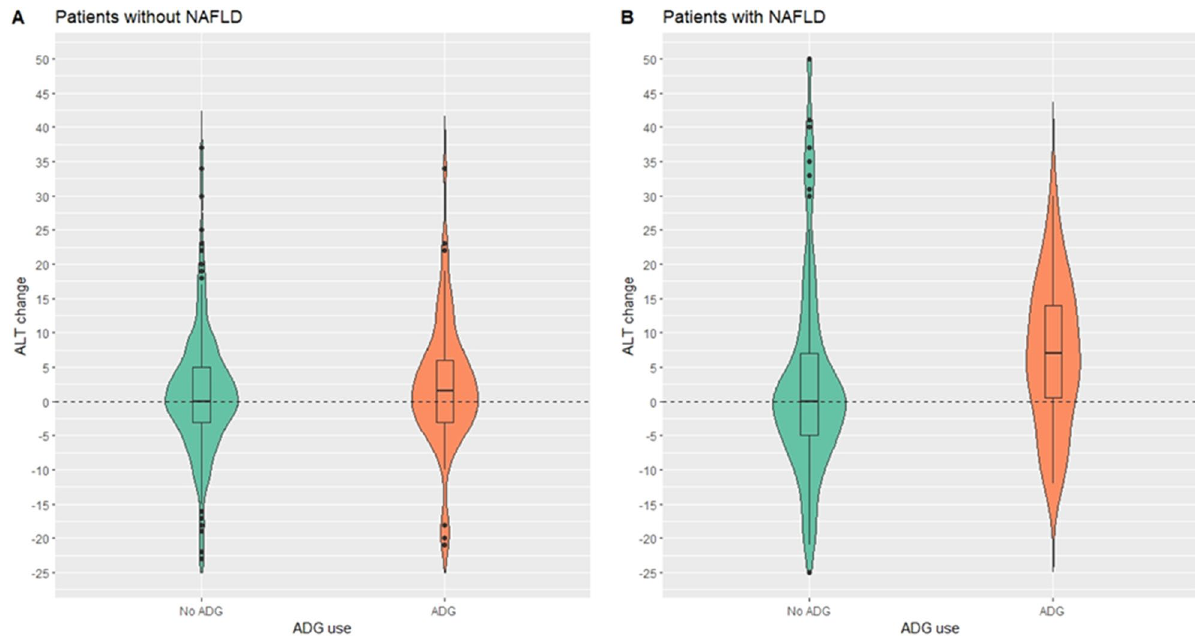
Figure 1. Violin plot of alanine aminotransferase (ALT) changes between Andrographis paniculata (ADG) VS control group stratified by non-alcoholic fatty liver disease (NAFLD) status. ( A ) Patients without NAFLD, and ( B ) Patients with